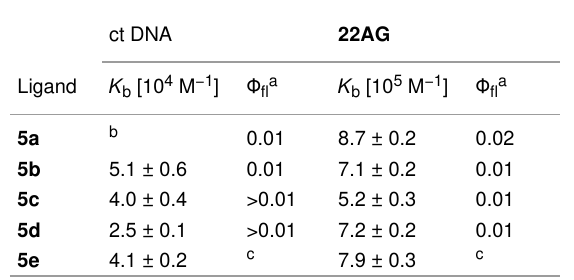
Table 3: Binding constants, K b , of 5a – e with ct DNA and G4-DNA 22AG , and fluorescence quantum yields of the DNA-bound